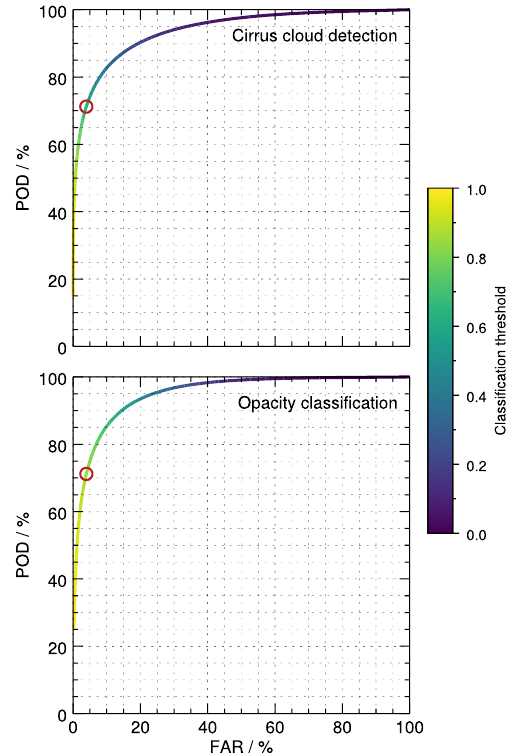
Figure 3. The POD and FAR of the CiPS cirrus cloud detection and opacity classification ANNs as a function of classification thresh- old. The red circles indicate the final thresholds selected for the two